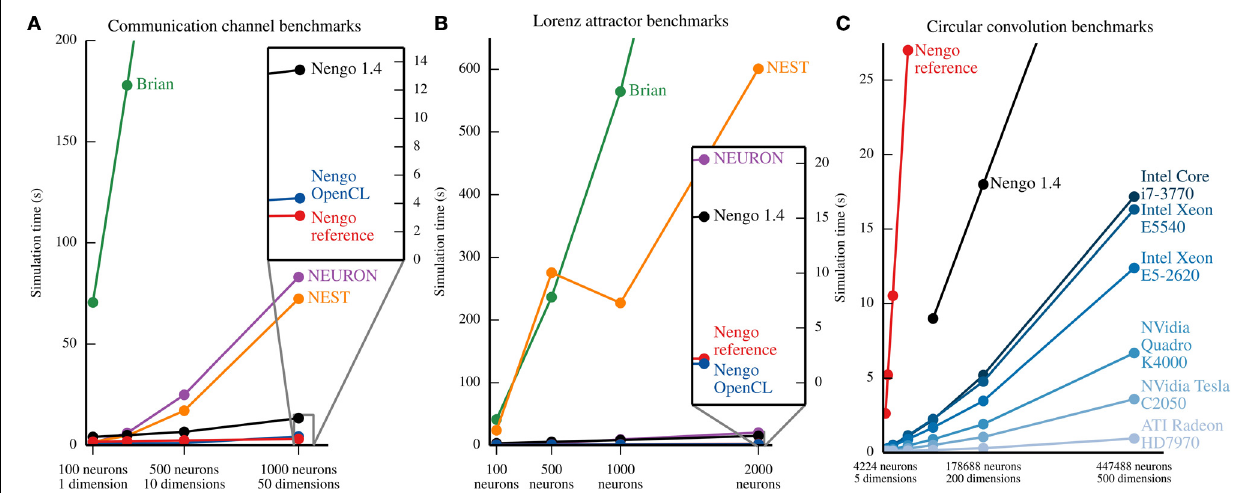
FIGURE 7 | Benchmark results for several simulators on the example models described in section 5. In (A) and (B) , all of the simulators except the Nengo OpenCL simulator were run on an Intel Core i7-965. Nengo 1.4 used all 4 cores of this processor; all other simulator used only 1 core. The Nengo OpenCL simulator was run on an NVidia GTX280 GPU. (A) Benchmark results from simulating the communication channel for 10 simulated seconds at a 1ms timestep. For all model sizes, Nengo simulators are faster than Nengo 1.4, which is significantly faster than NEURON and NEST, which are significantly faster than Brian. The full Brian results are not shown; for the largest model, the Brian simulation takes ∼ 768s. (B) Benchmark results from simulating the Lorenz attractor for 10 simulated seconds at a 1ms timestep. For most model sizes, the results